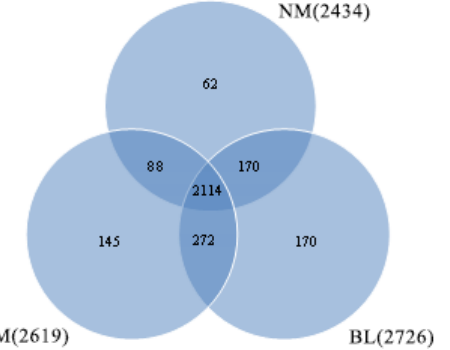
Figure 1. Venn diagram showing the number of unique and common operational taxonomic units for soil microbes in the three treatments. NM: non-mulched spring maize (control); PM: plastic-mulched spring maize; BL: bareland fallow. n = 3 (NM, PM, BL).